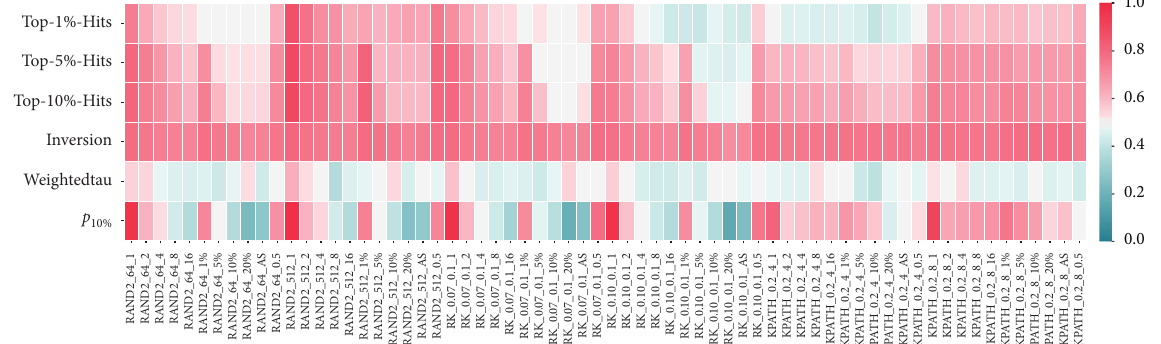
Figure 6: Average measure values of 66 competitors on 45 random